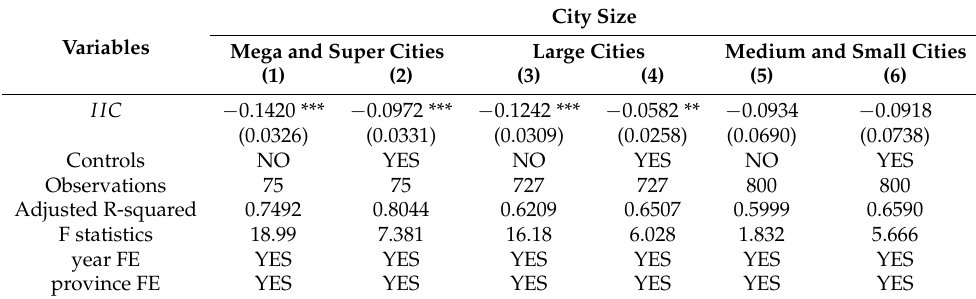
Table 4. Heterogeneity analysis: city